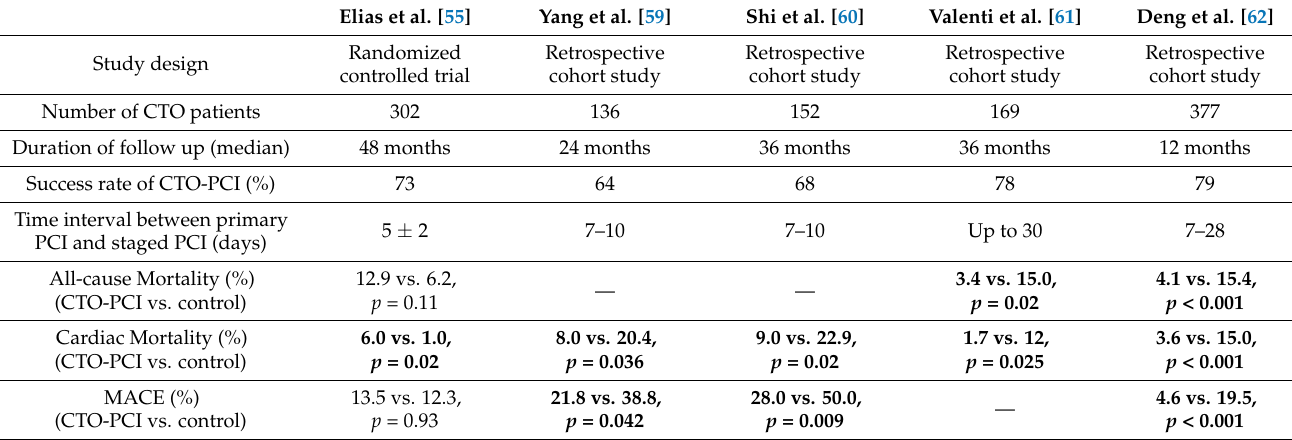
Table 1. Clinical trials evaluating prognostic impact of a staged non-infarct-related coronary artery (IRA) chronic total occlusion percutaneous coronary intervention (CTO-PCI) in ST-segment elevation myocardial infarction (STEMI)